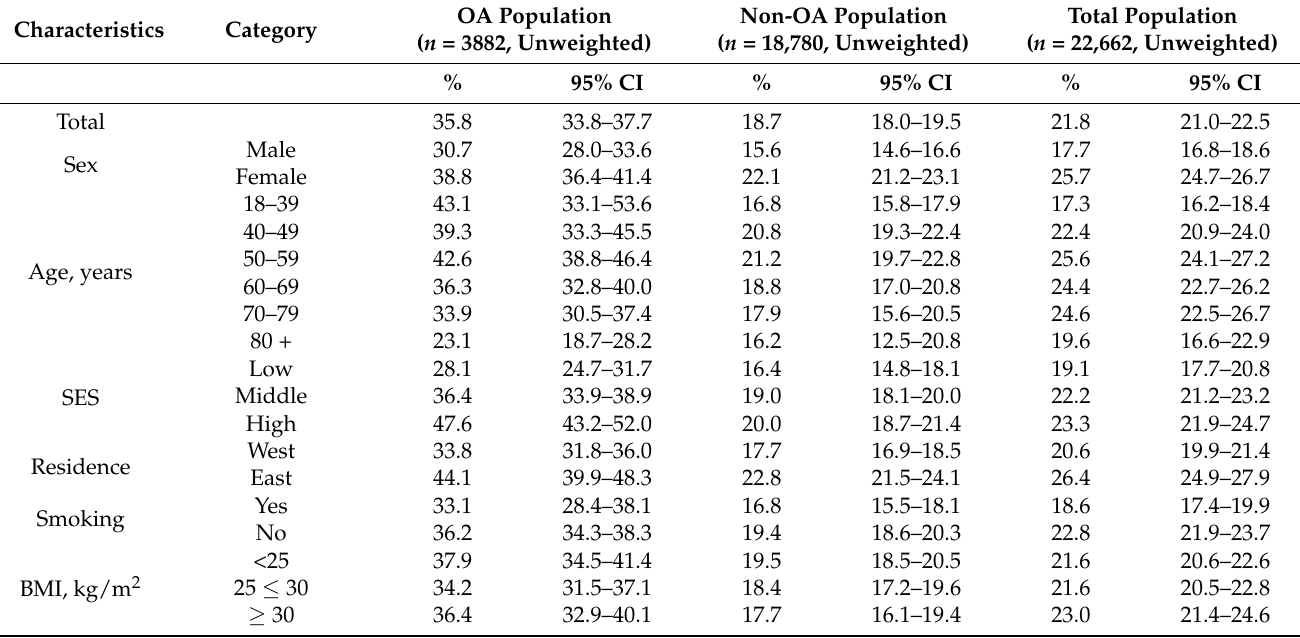
Table 2. Utilization of physical therapy within OA, Non-OA and total population depending on covariates ( n = 22,662, unweighted) in % (weighted) and 95%